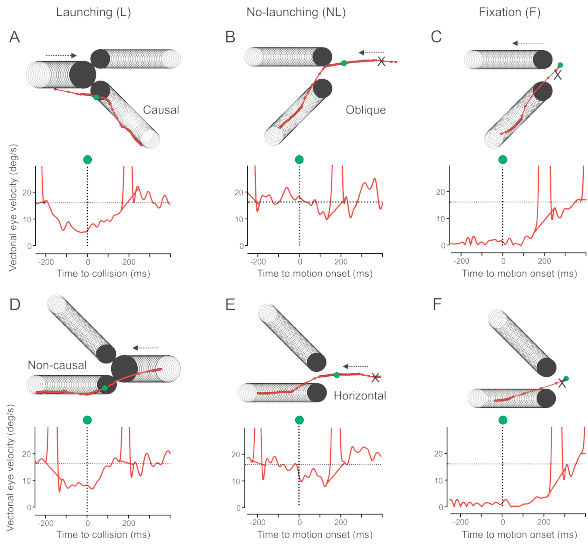
Figure 2. Examples of representative single trials. Upper row: Causal or oblique selections, lower row: non-causal